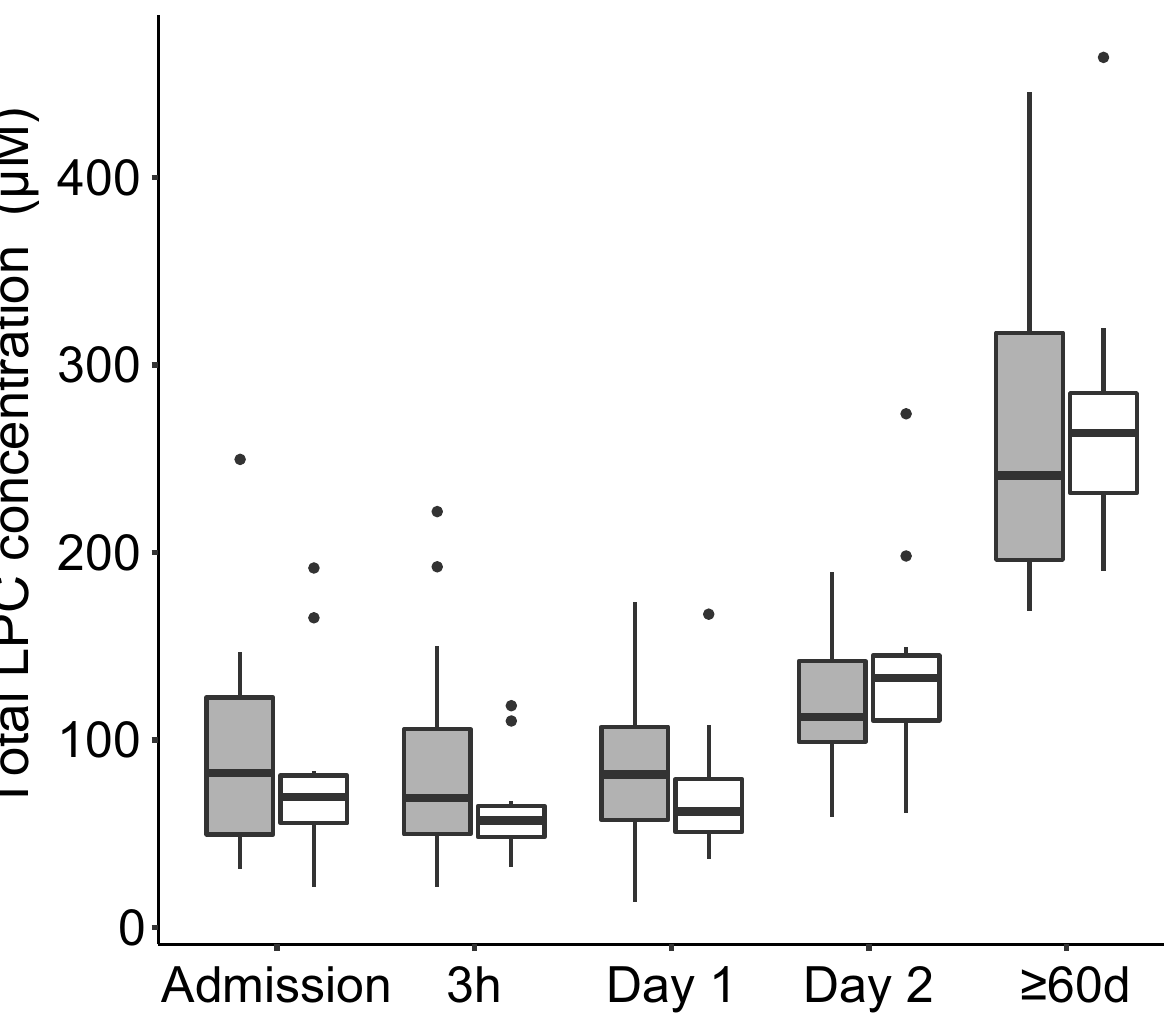
Fig 1. Boxplot diagram showing the distribution of total LPC concentrations at the different sampling time points from admission to full recovery after � 60d. Females are shown in gray boxes and males in white boxes. Outliers are shown as dots. Abbreviations: LPC,